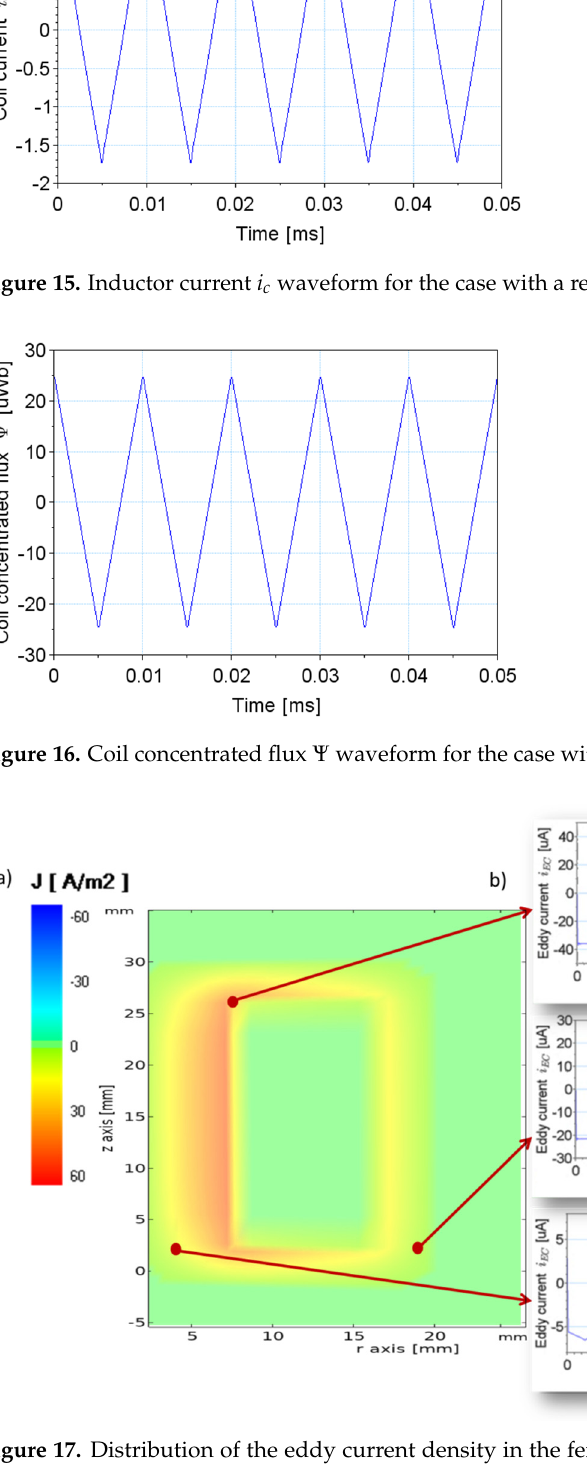
Figure 18. Distribution of the displacement current density in the ferrite core for time t = 5 us ( a ) and the waveforms of the displacement currents for three selected points of ferrite core ( b ) for a fre- quency of 100 kHz. 4. Results Validation The validity of the obtained results has been verified by means of Comsol Multiphys- ics software. The simulation was done on a field model of the electromagnetic inductor